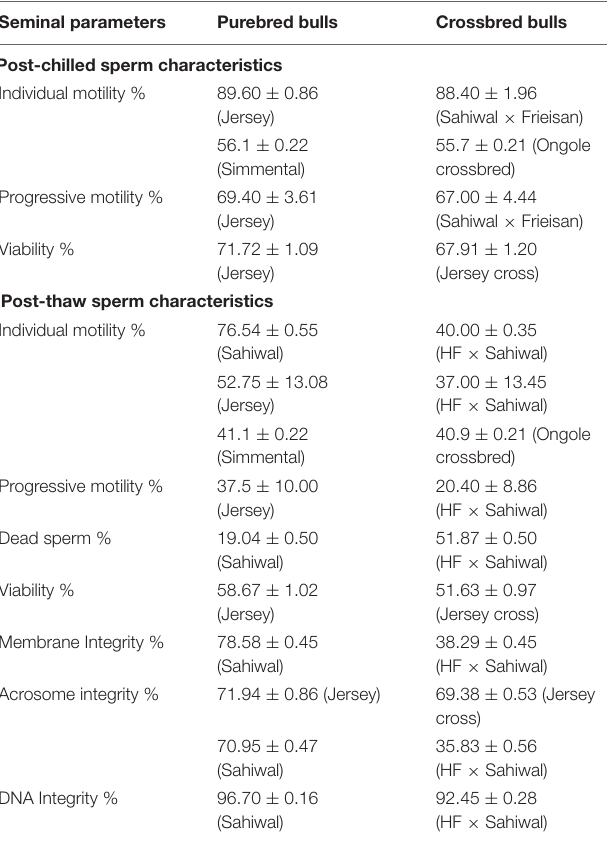
TABLE 1 | Cryo-tolerance between purebred and indigenous bulls (based on the data from Kumar et al., 2015; Khan et al., 2018; Chung et al., 2019; Isnaini et al., 2019).